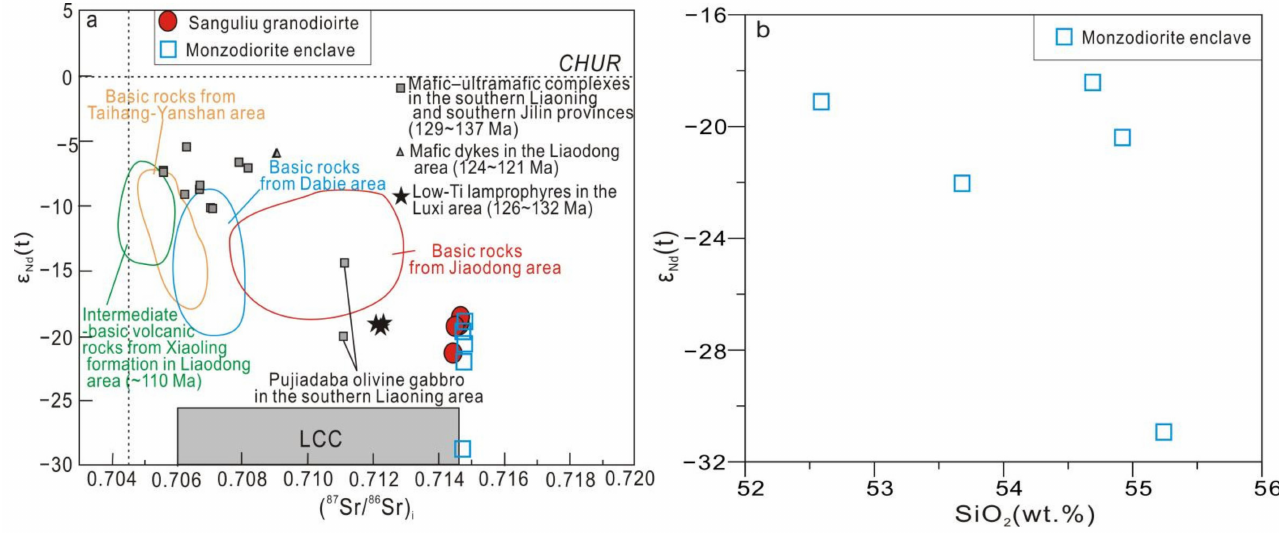
Figure 10. ε Nd (t) versus ( 87 Sr/ 86 Sr) i plot ( a ) and SiO 2 versus ε Nd (t) diagram ( b ). The data of the mafic rocks in the Taihang-Yanshan area are sourced from [50,51]; those in the Dabie area are from [52–54]; those in the Jiaodong area are from [55–57]; those in the Southern Jilin and Southern Liaoning areas are from [58]; the intermediate-basic rocks from the Liaodong area are from [59,60]; lamprophyres in the Luxi area are from [61]; LCC–lower crust of the NCC, which was taken from [62]. Moreover, the host granodiorite and monzodioritic enclave generated similar Pb isotopic ratios: ( 206 Pb/ 204 Pb) i = 17.6200–17.8360, ( 207 Pb/ 204 Pb) i = 15.5970–15.6190, and ( 208 Pb/ 204 Pb) i = 38.8410–39.9490, as summarized in Table 6 and Figure